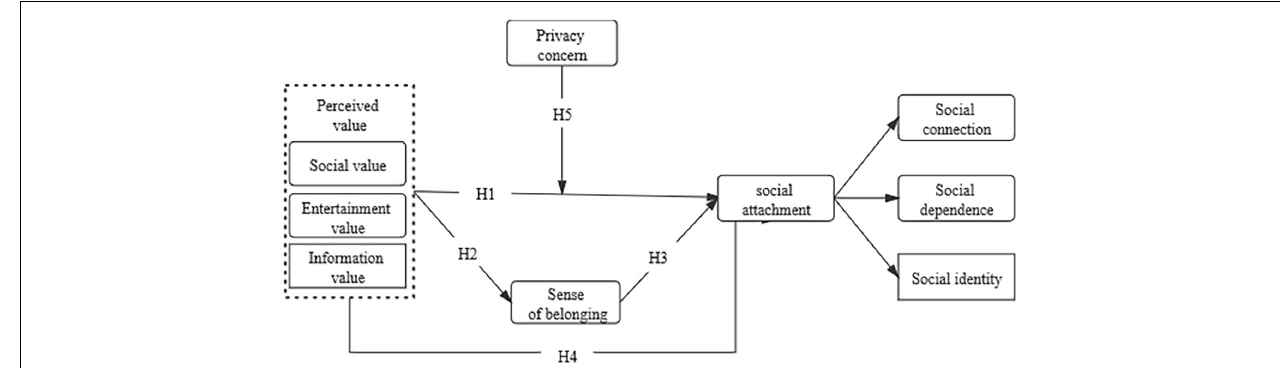
FIGURE 1 | Theoretical